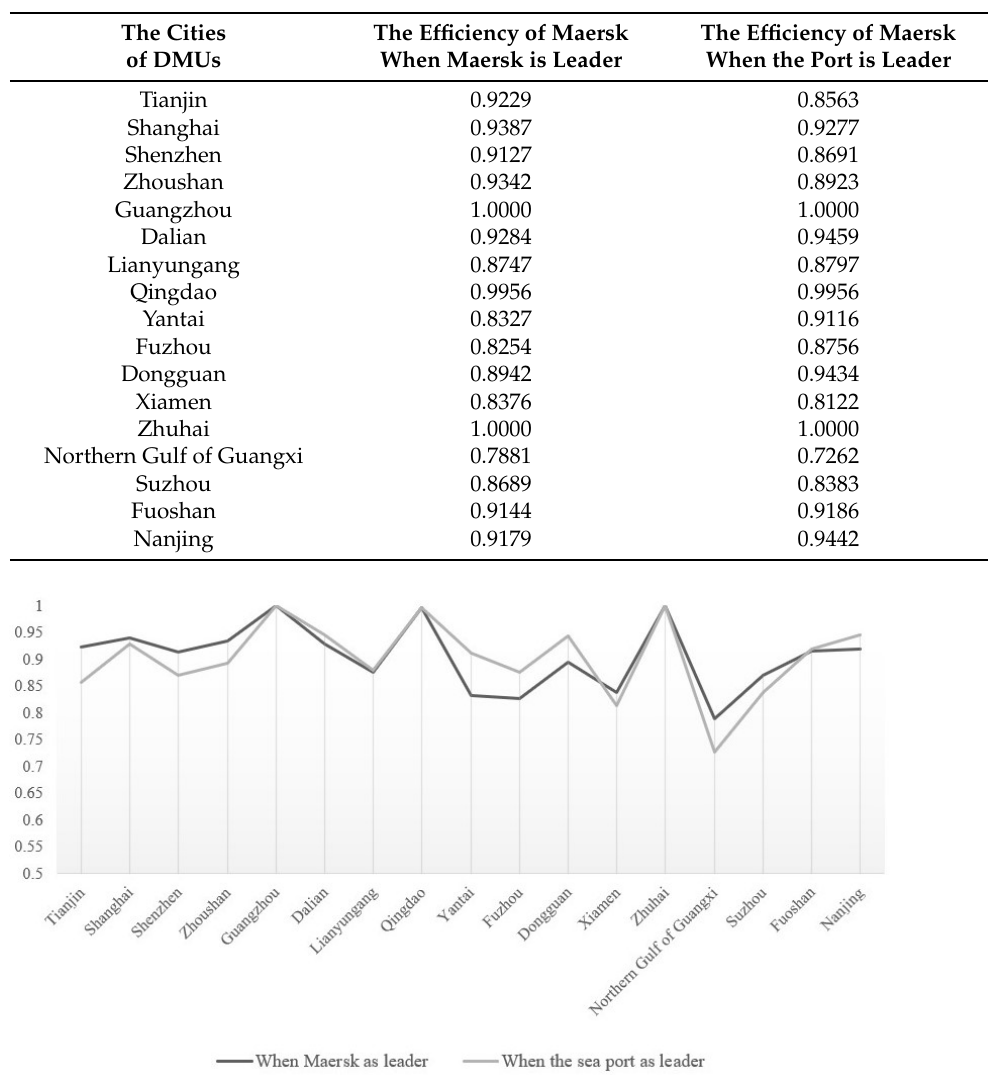
Table 4. The sustainable efficiency of Maersk with different leaders.